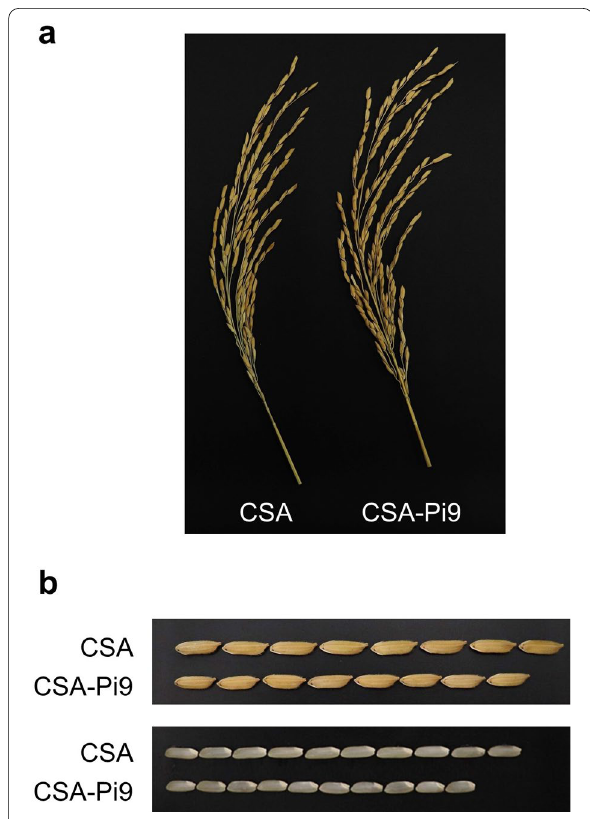
Fig. 6 Comparison of the panicle shape ( a ) and grain shape with and without the hull ( b ) of CSA‑Pi9 and CSA plants grown in field A (normal irrigation condition) in